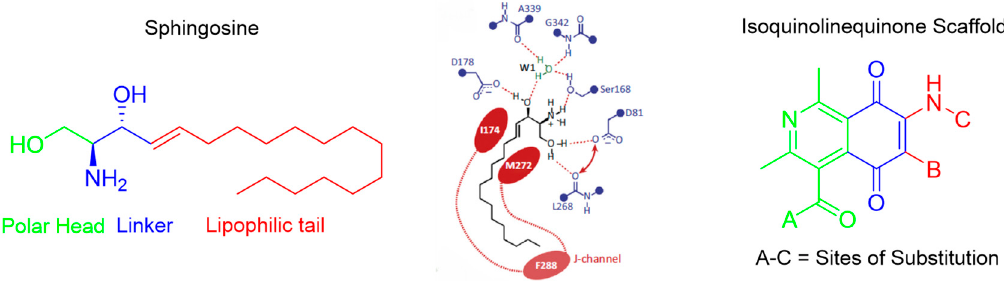
Figure 1. Sphingosine docking into the narrow J-channel in the active site of SK1. Transposing the general regions of sphingosine onto the proposed isoquinolinequinone template affords a versatile, novel potential